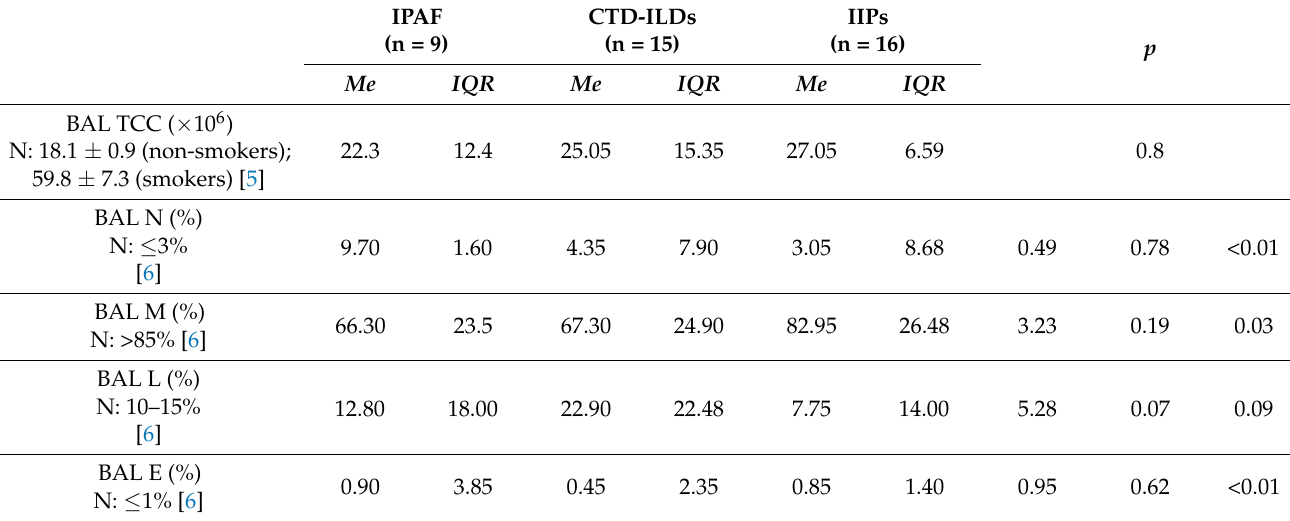
Table 2. Patient comparison in terms of BAL parameters.